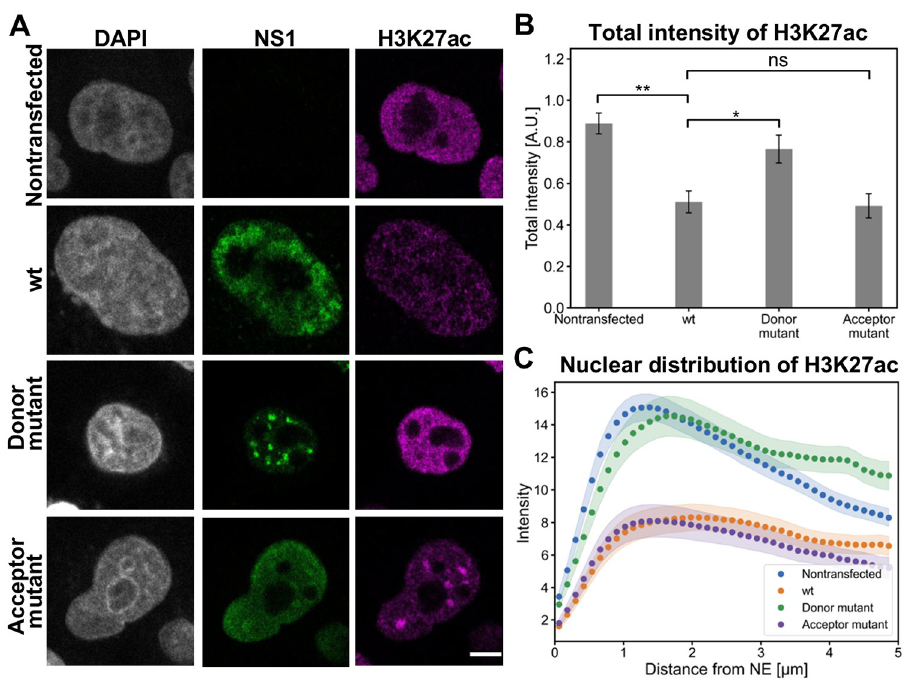
Fig 7. NS2 mutation induce changes in the amount and distribution of euchromatin. ( A ) Representative confocal images show the nuclear localization of euchromatin marker H3K27ac (magenta), NS1 (green), and DAPI staining (gray) in nontransfected HeLa cells, and cells transfected with wt, NS2 donor and acceptor mutants at 24 hpt. ( B ) Total fluorescence intensities of euchromatin. ( C ) Nuclear distribution of H3K27ac as a function of increasing distance from the NE in nontransfected, wt and NS2 mutants transfected cells (n = 29). The error bars show the standard error of the mean. Statistical significances were determined using Dunnett’s multiple comparison test. The significance values shown are denoted as �� (p < 0.01), � (p < 0.05) or ns (not significant). Scale bars, 5 μ